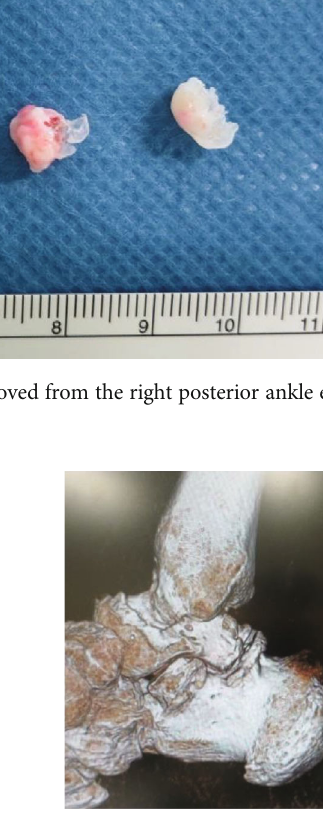
Figure 9: Three-dimensional computed tomography scan obtained postoperatively shows no ossi fi ed lesions in the posterior